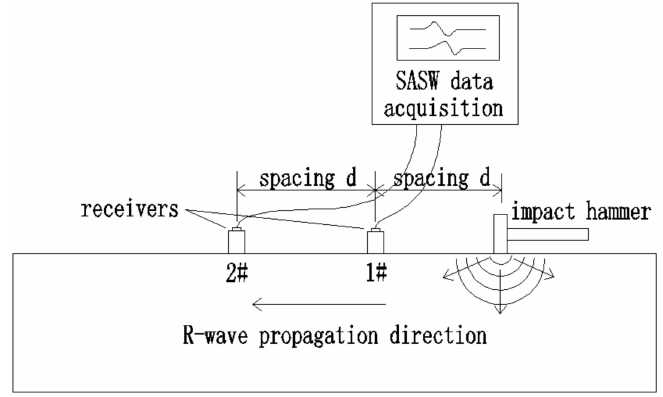
Figure 2. Schematic layout of the SASW